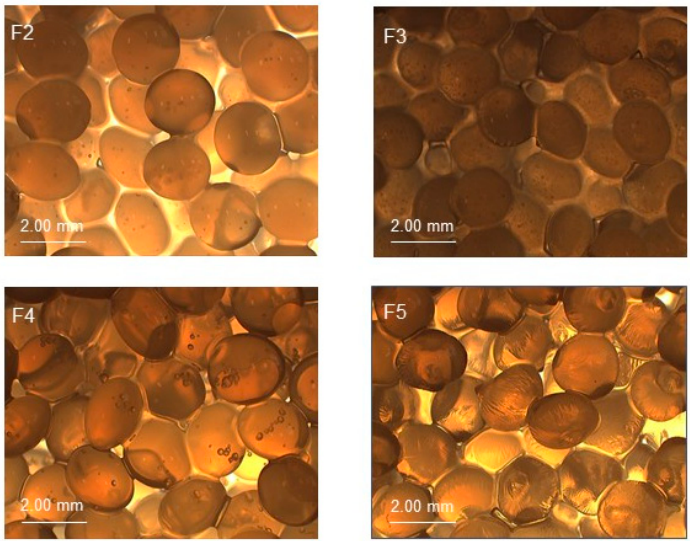
Figure 1. The microscopic pictures of millibeads F2–F5 unloaded with 5 ‐ ASA.